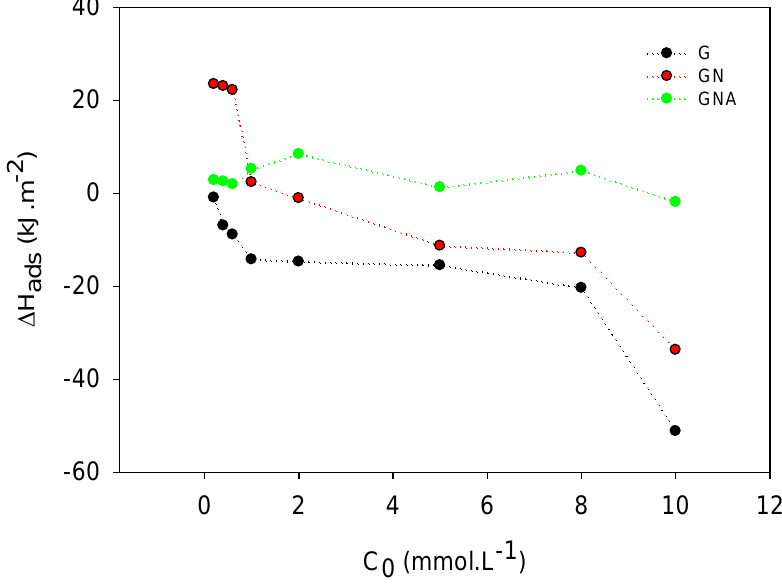
Figure 9. Changing the enthalpy as a function of the phenol concentration in the solution.